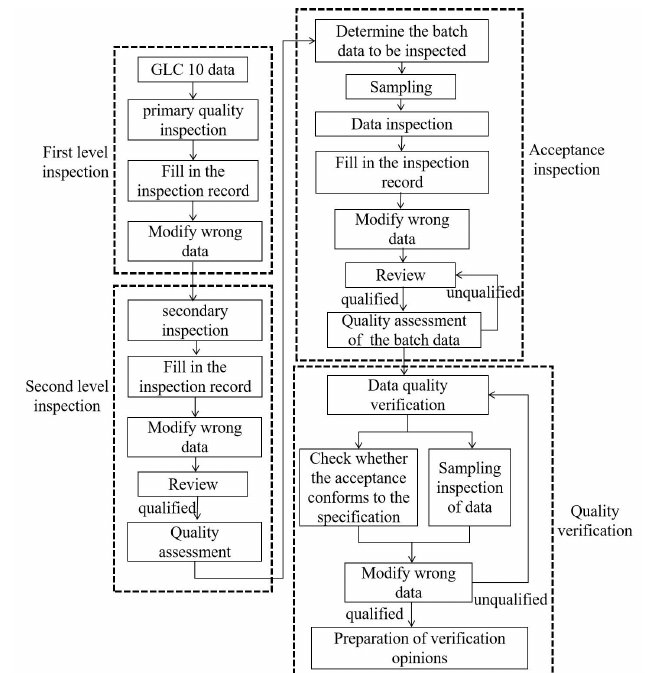
Figure 2 . The quality control process of GLC 10